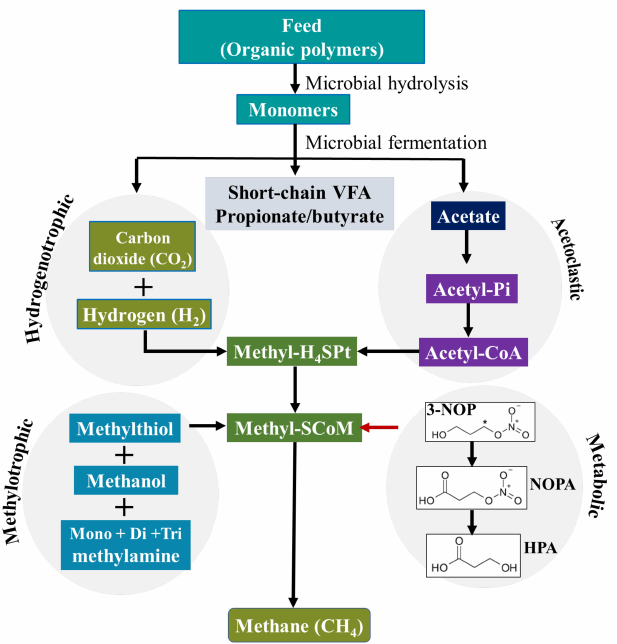
Figure 1. The main CH 4 formation pathway in the rumen of ruminants and its inhibition by 3-NOP [28,29]. (3-NOP = 3-nitrooxypropanol; NOPA = 3-nitrooxypropionic acid; HPA = 3- hydroxypropionic